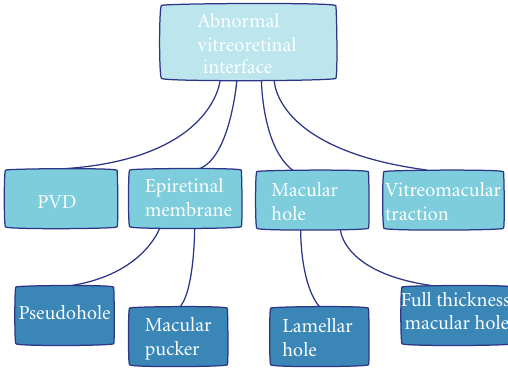
Figure 2: Vitreoretinal-interface-associated pathologies.